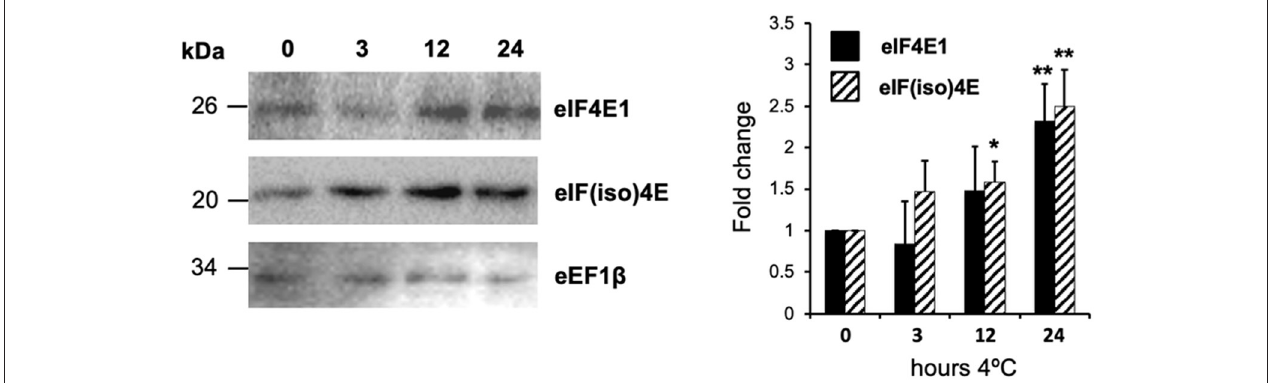
FIGURE 1 | Translation factors eIF4E1 and eIF(iso)4E expression is upregulated by low temperatures. Two weeks old plantlets were placed in a cold chamber at 4 ◦ C under a 16h light/8h darkness photoperiod (long day) for 24h. Protein levels were evaluated by Western blot and translation elongation factor eEF1 β was used for normalization. The graph at the right represents protein level measurements by blot densitometry of three replicates. Data are presented as mean fold change with respect to control plants before cold exposure. Student’s t -test was used to evaluate statistically significant differences: * p < 0.05, ** p < 0.01.